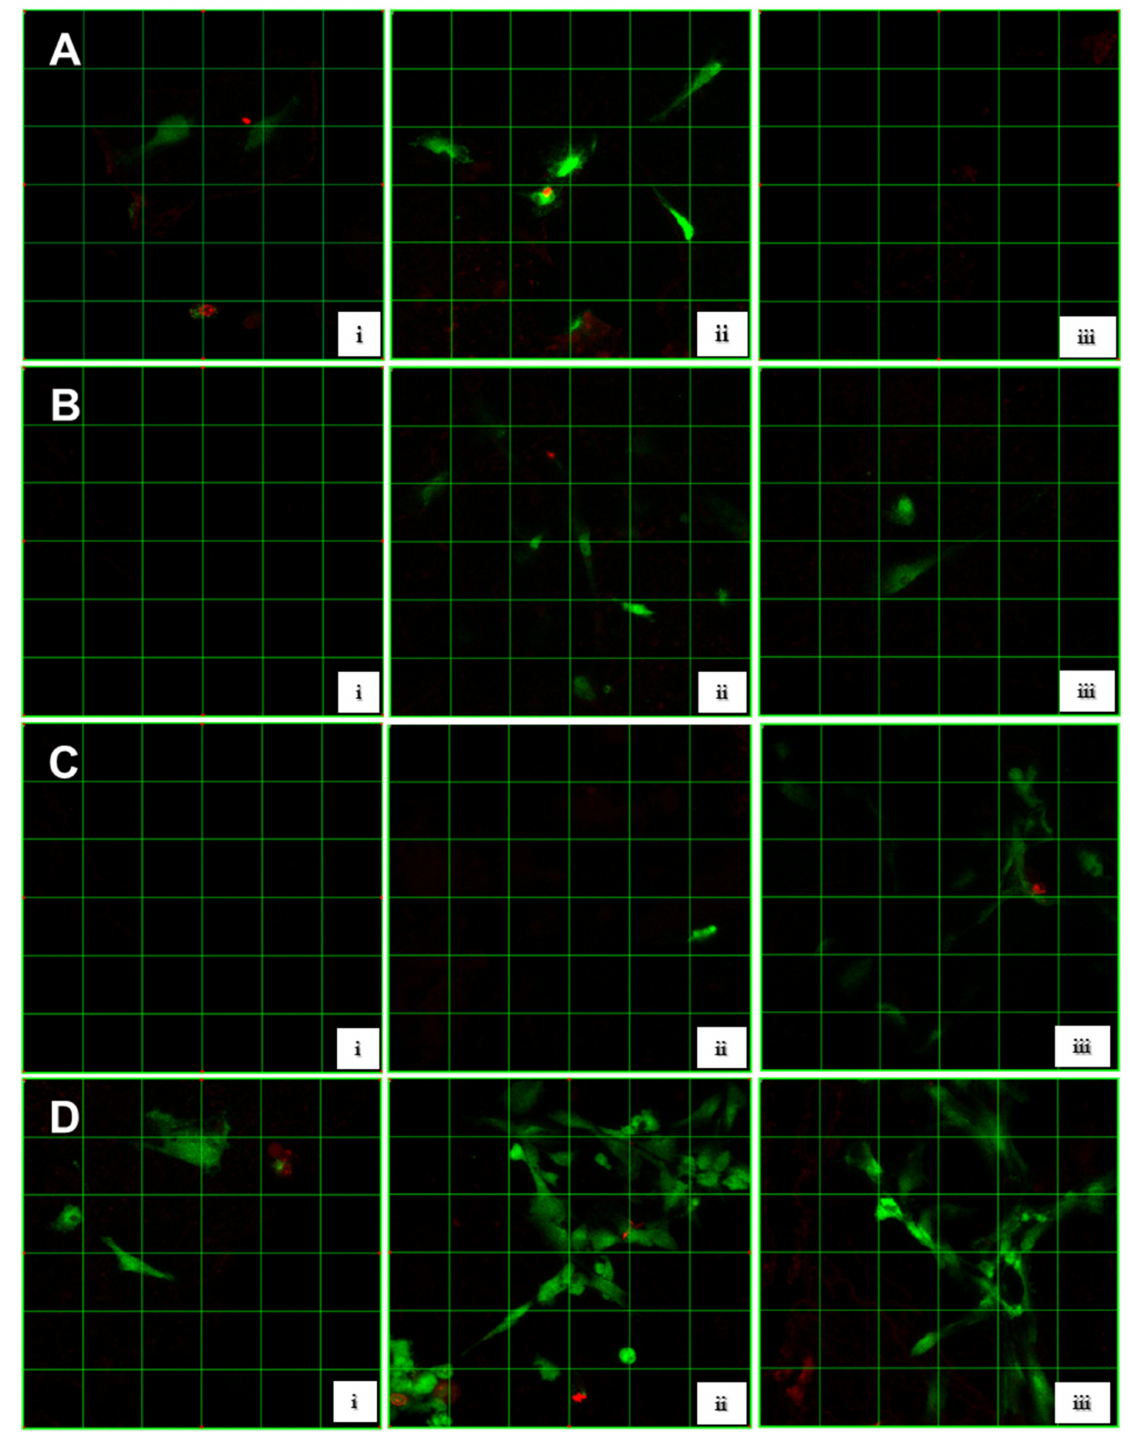
Figure 2. Images captured under a confocal fluorescence microscope (CFM); n = 3 (i, ii, iii). ( A ). HAp-egg shell/PLGA + HPdLF. ( B ). HAp-egg shell/PLGA + HPdLF + Collagen. ( C ). HAp-egg shell/PLGA + HPdLF + PRF. ( D ). HAp-egg shell/PLGA + HPdLF + PRF + Collagen. Live cells are green, dead cells are